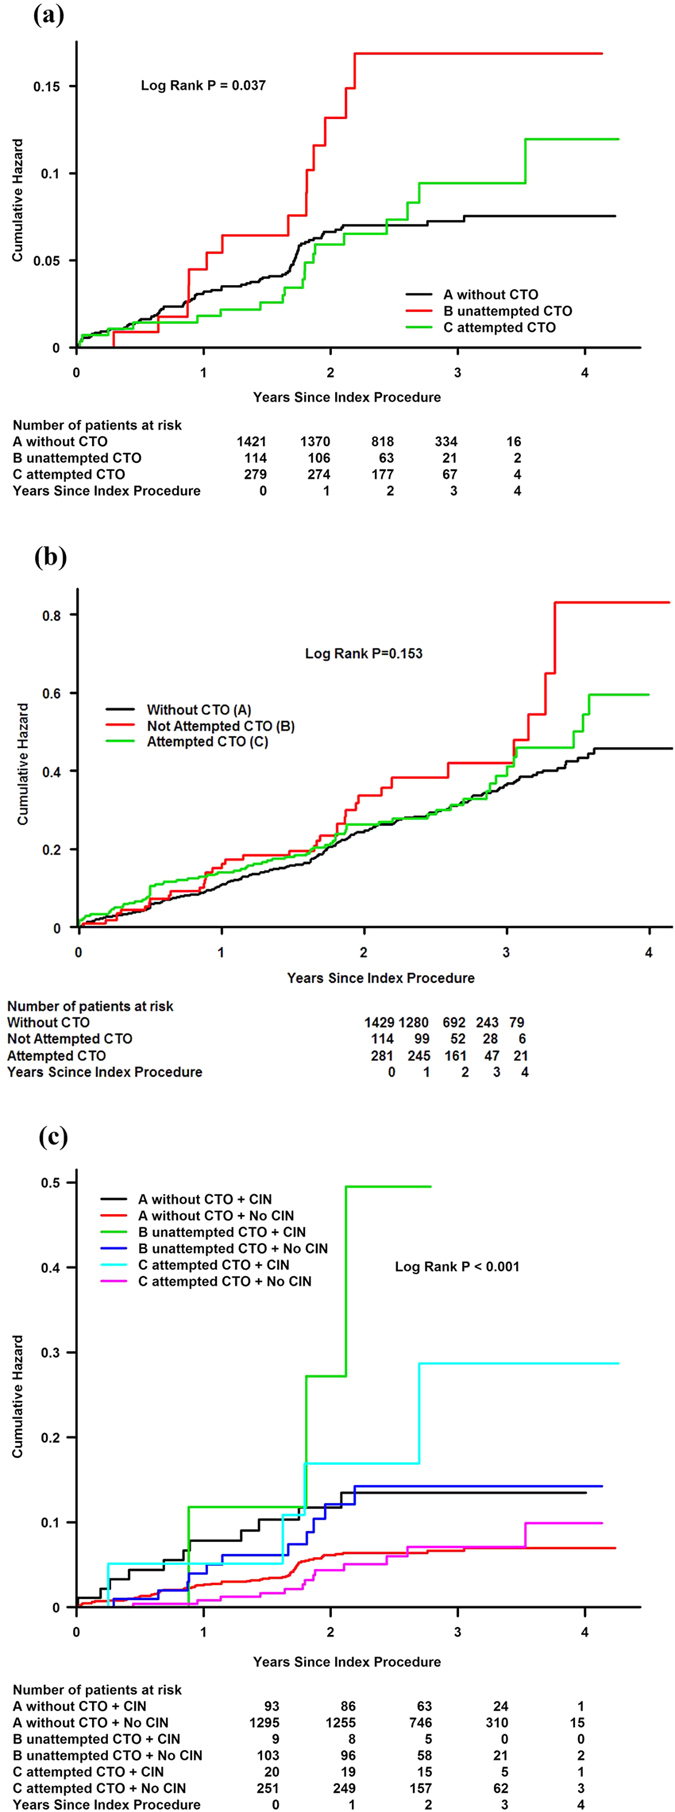
Kaplan-Meier Curves Showing Cumulative Probability of Mortality and Major Adverse Clinical Events.(a) Kaplan-Meier curves showing cumulative probability of mortality. (b) Kaplan-Meier curves showing cumulative probability of major adverse clinical events. (c) Kaplan-Meier curves showing cumulative probability of mortality.